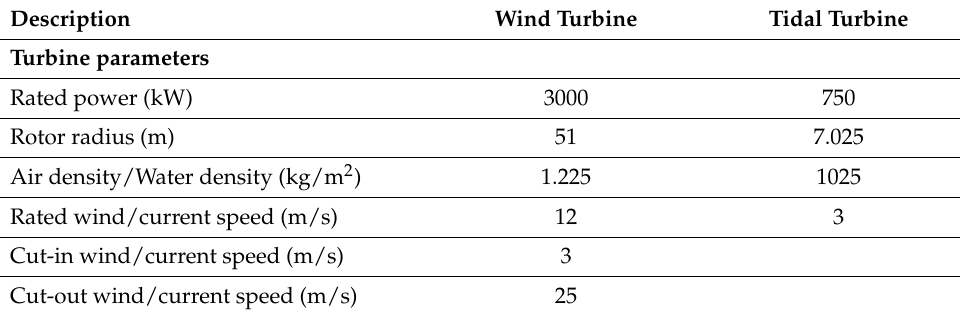
Table A1. Parameters list of wind and tidal